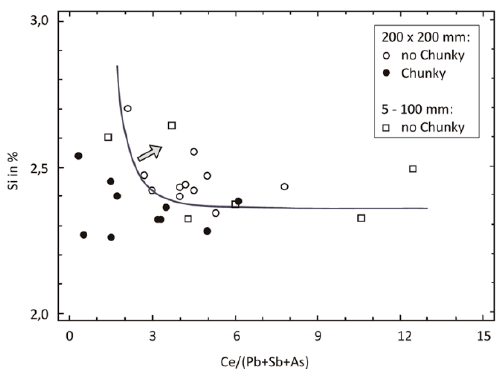
Figure 40. Maximum tolerable Si content to avoid chunky graphite, Si is in mass%, and the elements on the abscissa are in ppm, 3.40% ≤ C ≤ 3.77%, reproduced from [13,141] with permission from Springer.